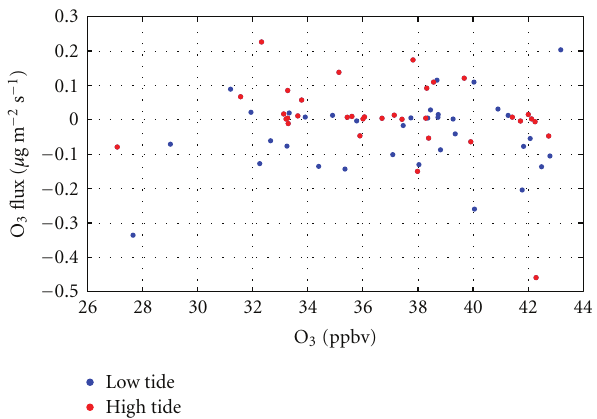
Figure 5: Scatter plot of O 3 fluxes versus O 3 mixing ratios showing a relatively low correlation between both data sets ( r 2 = 0 . 038). High-tide and low-tide fluxes are also shown by di ff erent coloured